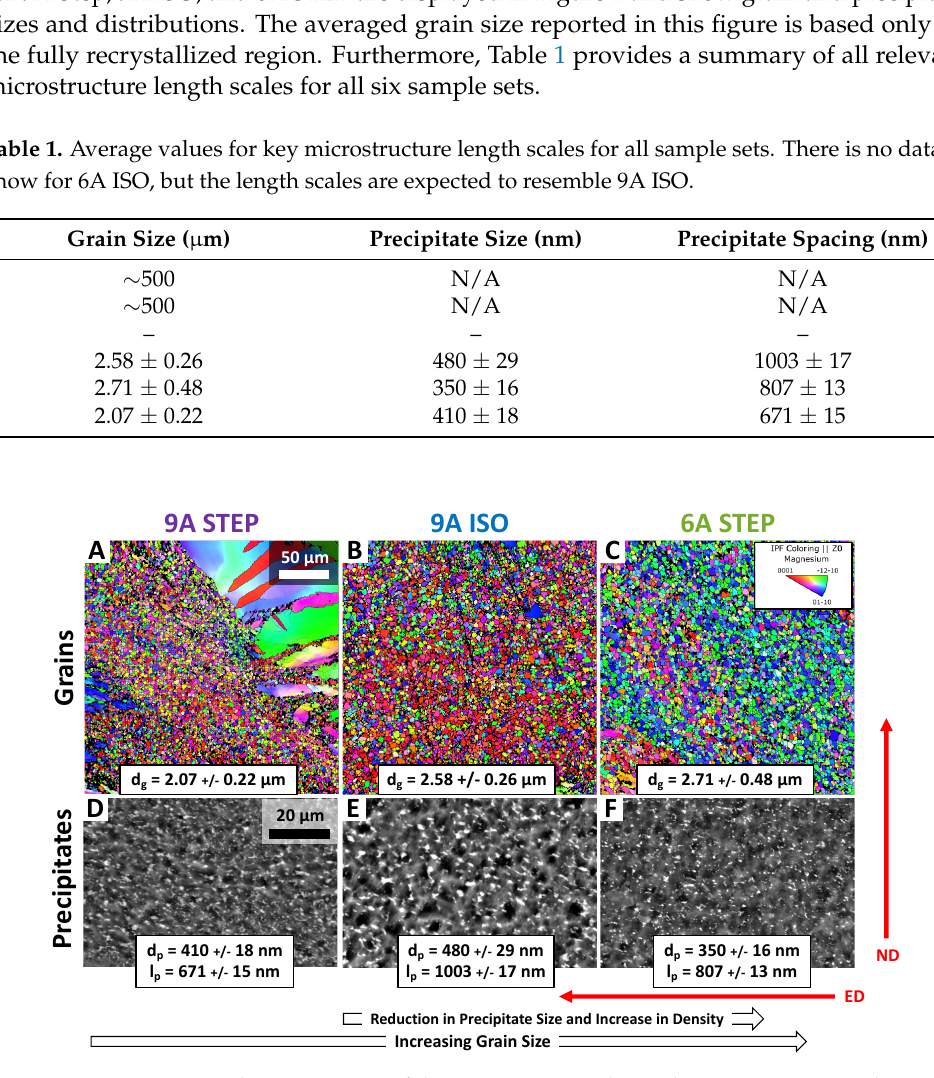
Figure 1. Microstructure characterization of the ECAE-processed samples. EBSD Inverse Pole Figures (IPFs) showing characteristic grain size, distribution, and orientation for ( A ) 9A STEP, ( B ) 9A ISO, and ( C ) 6A STEP. Backscattered electron micrographs showing the precipitate size and spacing for ( D ) 9A STEP, ( E ) 9A ISO, and ( F ) 6A STEP. The sample orientation is shown by the solid arrows in the lower right-hand corner to indicate the extrusion direction (ED) and normal direction (ND). (Figure reproduced with permission from